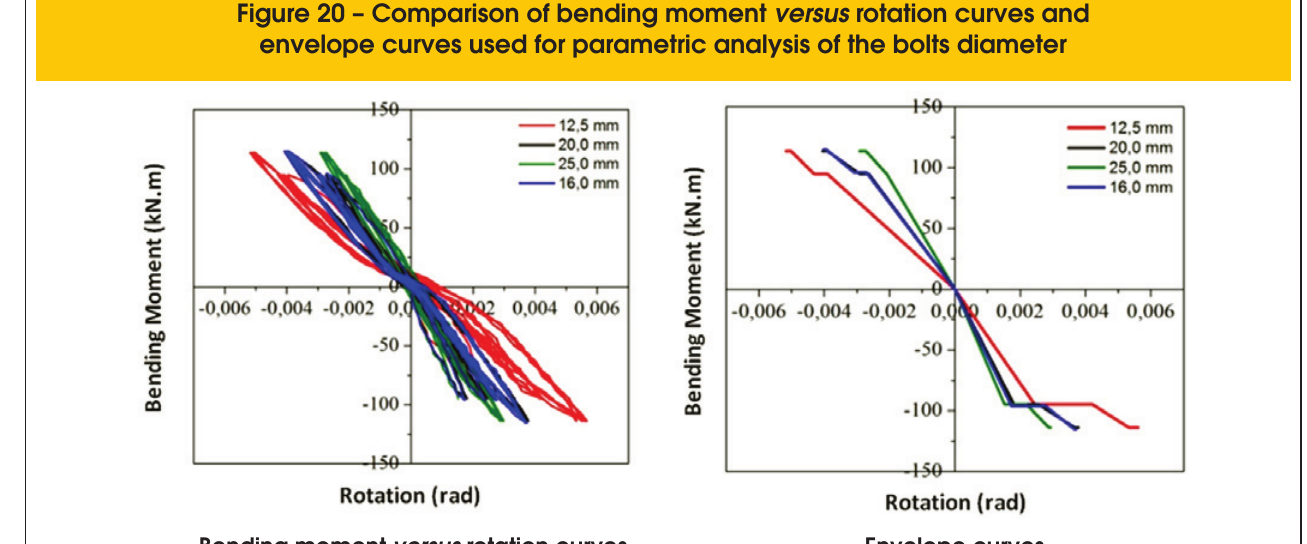
Bending moment versus rotation